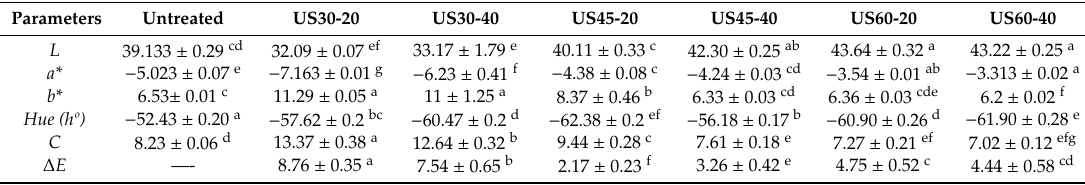
All values are indicated as mean ± stander deviation. Values with di ff erent letters in the same row are significantly di ff erent ( p < 0.05) from each